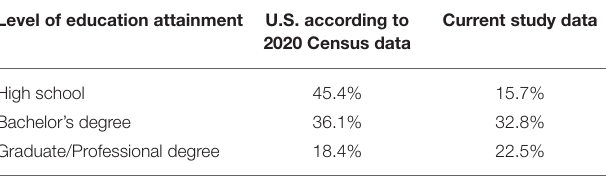
TABLE 4 | Educational attainment of study respondents as compared with 2020U.S. Census values * .